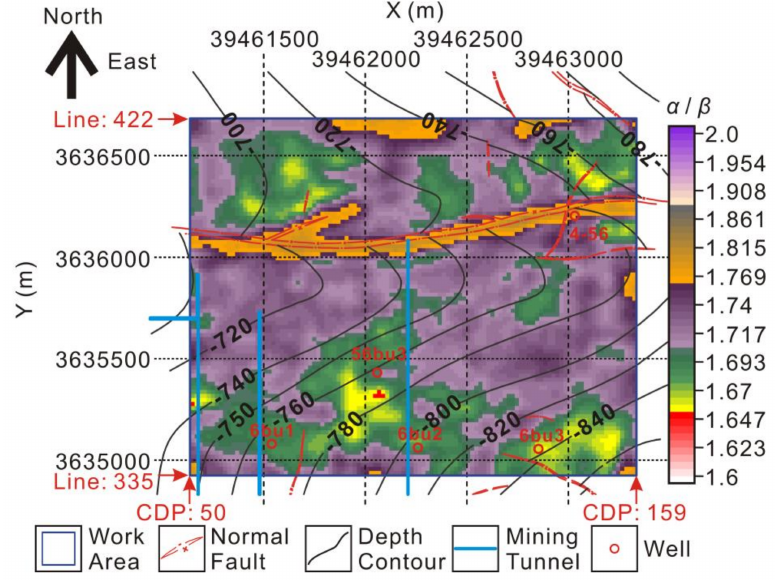
Figure 11. Slice of P- to S-wave velocity ratios in the middle of coal seam